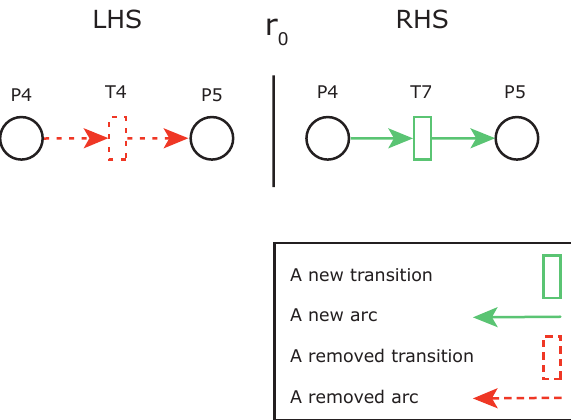
Figure 3. A GRR r 0 to replace transition T 4 with T 7 .